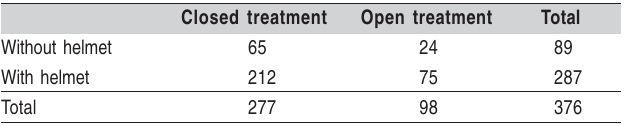
Table 5. Distribution of associated general trauma and the use of helmet